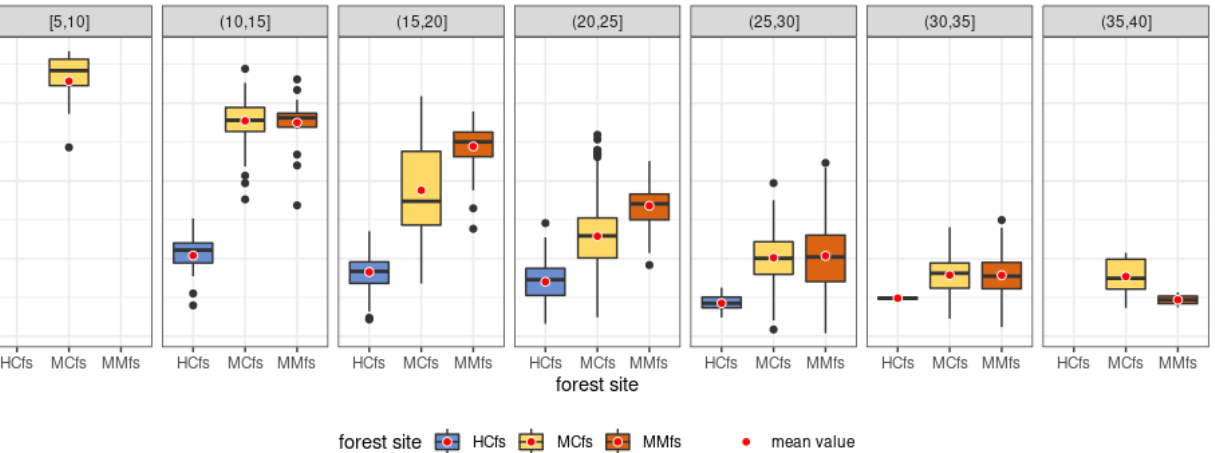
Figure 13. Distributions of ten years (2007–2017) of height growth of Scots pine trees across different forest site groups: hydrogenic coniferous forest sites (HCfs), mineral forest sites (MMfs), mineral mixed forest sites (MMfs).